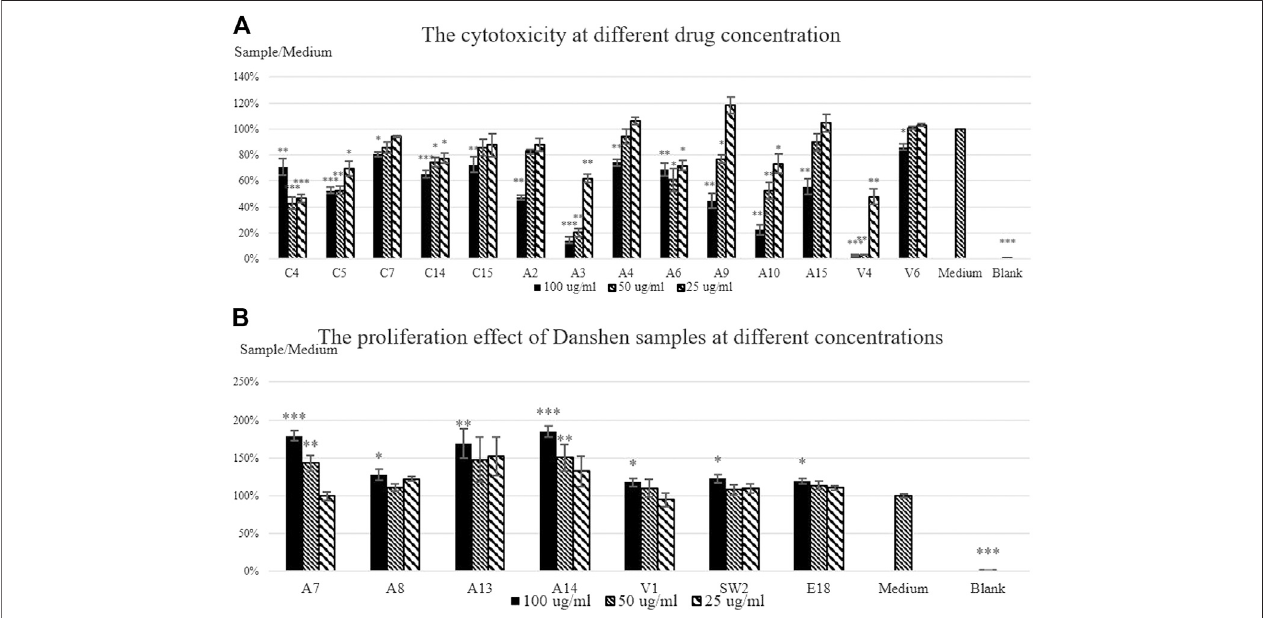
FIGURE6 | Thecell viabilityresults ofDanshen sample extracts in RAW 264.7. 200 μ lofRAW 264.7with thedensity of3 × 10 4 cells/ μ listreated with 100,50, and 25 μ g/ml of sample for 24 h. (A) the results of the samples showing the signi fi cant cytotoxic effect to RAW 264.7 (B) the results of the samples showing a proliferative effectinRAW264.7.0.05%DMSOwasusedasthecontroloftheexperiment.Thecellviabilitypercentageisthemeanabsorbanceofthesampleabsorbancedividedby the medium absorbance ± SEM of three triplicated independent experiments. Statistical signi fi cance of the sample is shown as * (cid:1) p < 0.05, ** (cid:1) p < 0.01, and *** (cid:1) p < 0.001 compared with the medium control.